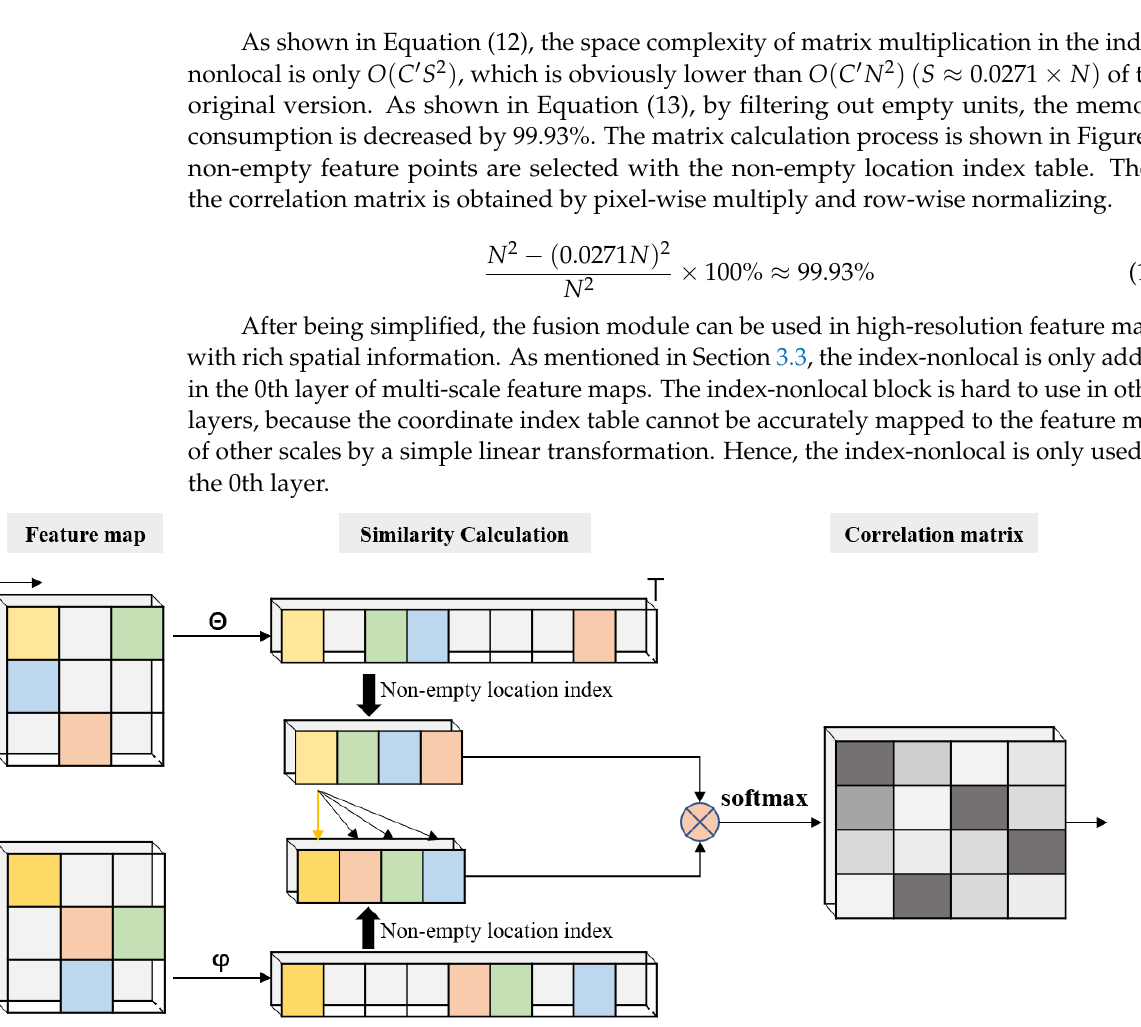
Figure 6. The correlation matrix calculation of index-nonlocal module. In the feature map and similarity calculation stage, grids with color represent non-empty units. The classes of color represent the similarity of feature points. In the correlation matrix, the gray level represents the relevance among feature